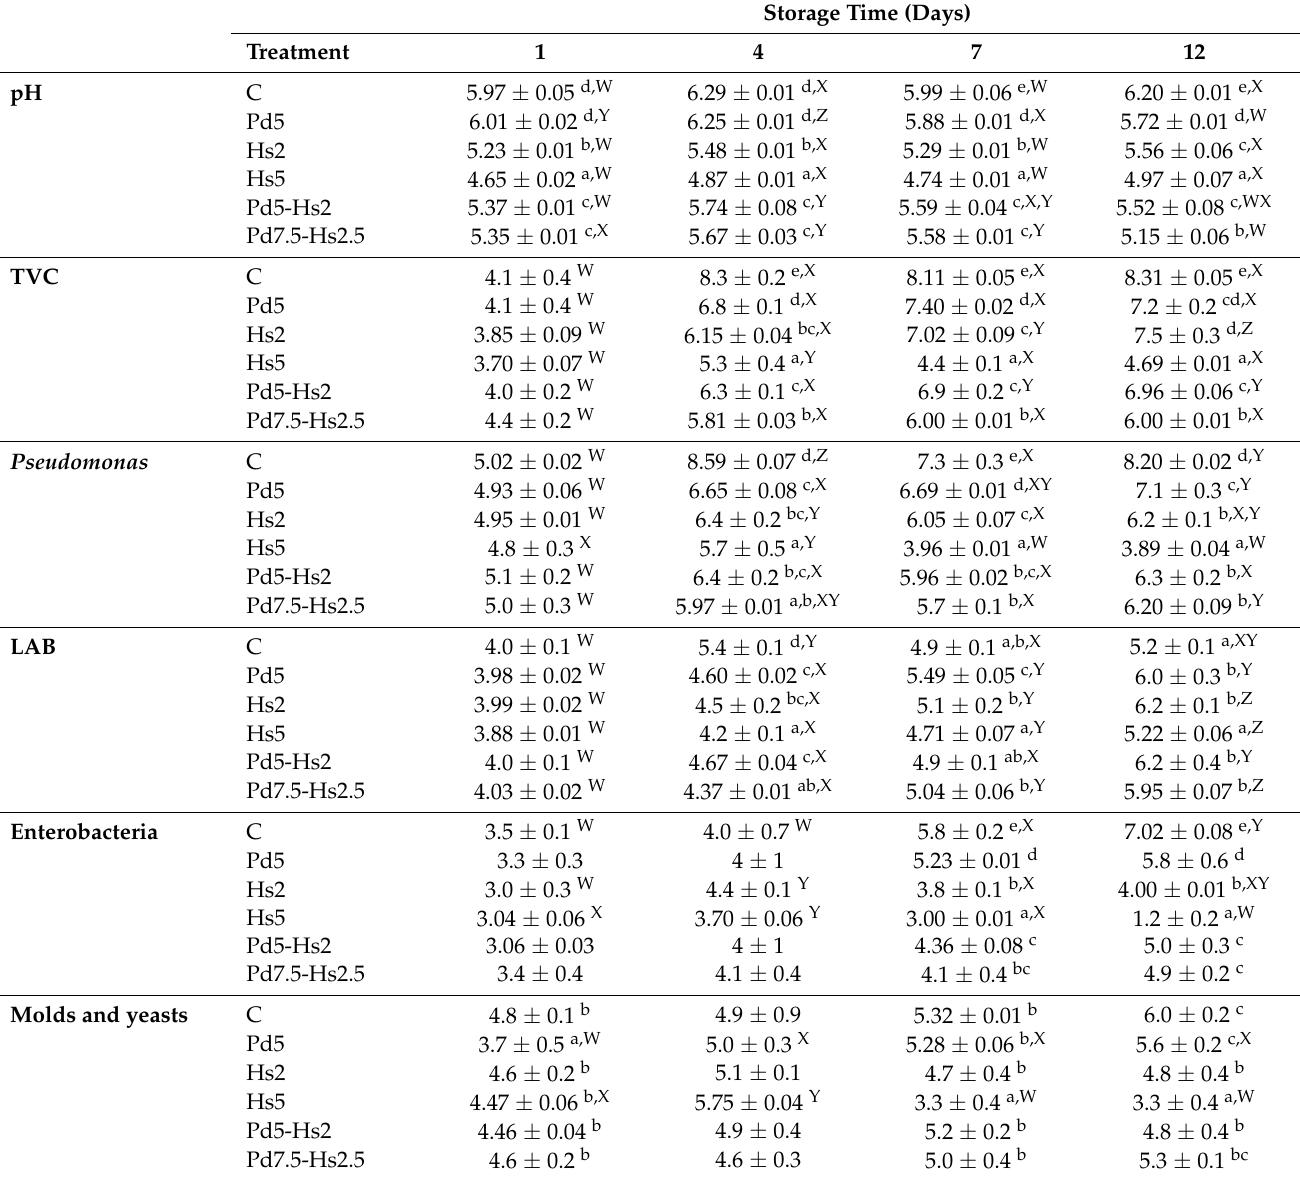
Table 3. Evolution of pH and microbial counts (Log CFU/g) of cold stored beef